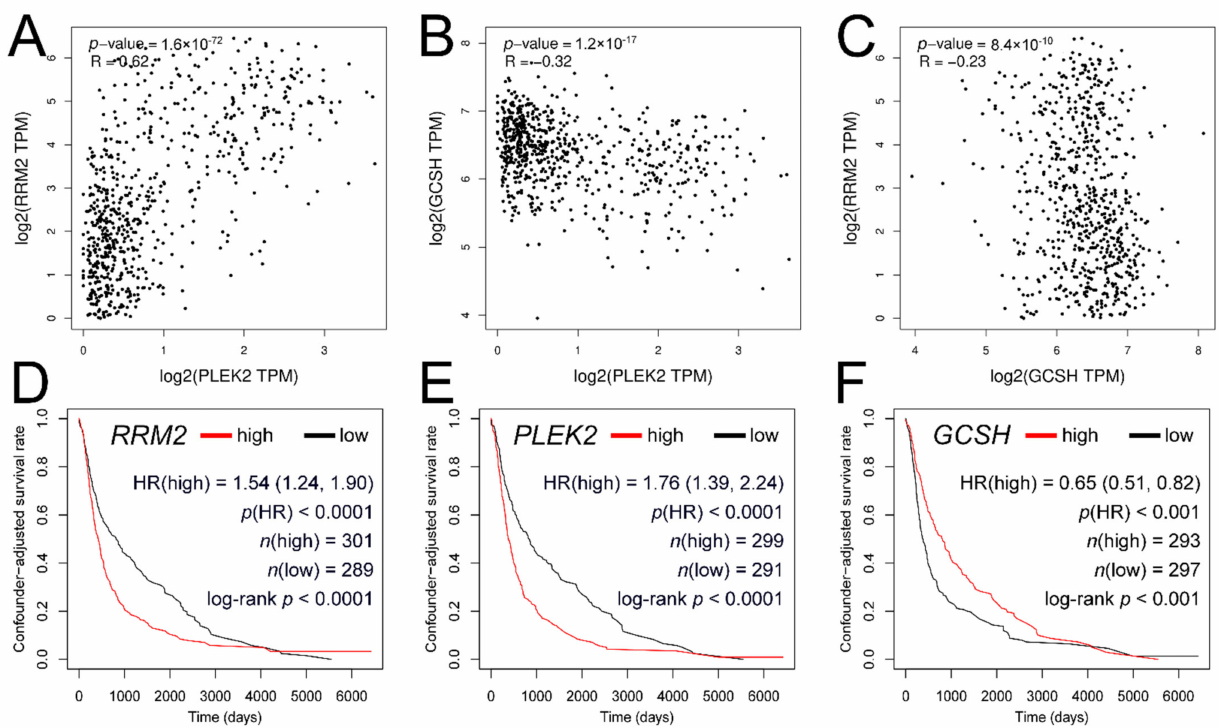
Figure 9. Correlation analysis of PLEK2 , RRM2 , and GCSH and its confounder-adjusted survival curves. ( A ) PLEK2 vs. RRM2 . ( B ) PLEK2 vs. GCSH . ( C ) GCSH vs. RRM2 . ( D ) ESTIMATE-adjusted survival for RRM2 . ( E ) ESTIMATE-adjusted survival for PLEK2 . ( F ) ESTIMATE-adjusted survival for GCSH